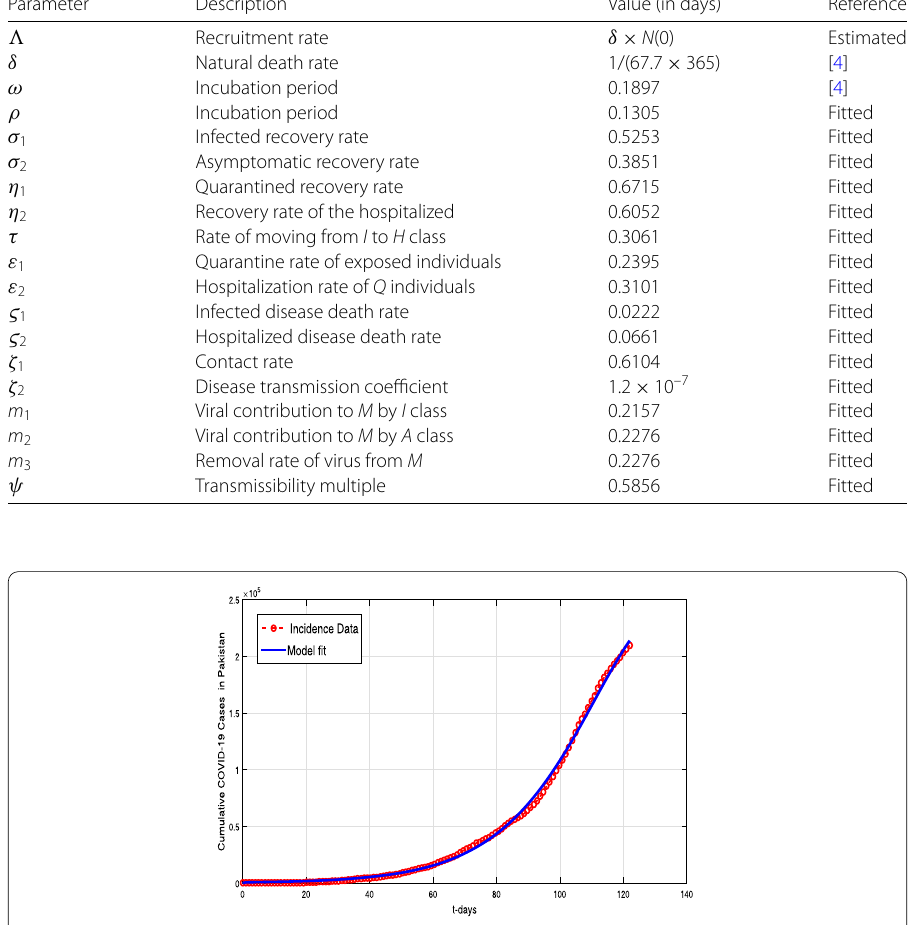
Figure 1 Curve fitting (solid red line) to the confirmed infected cases using model (6), while the data are consider from 1 March to 30 June